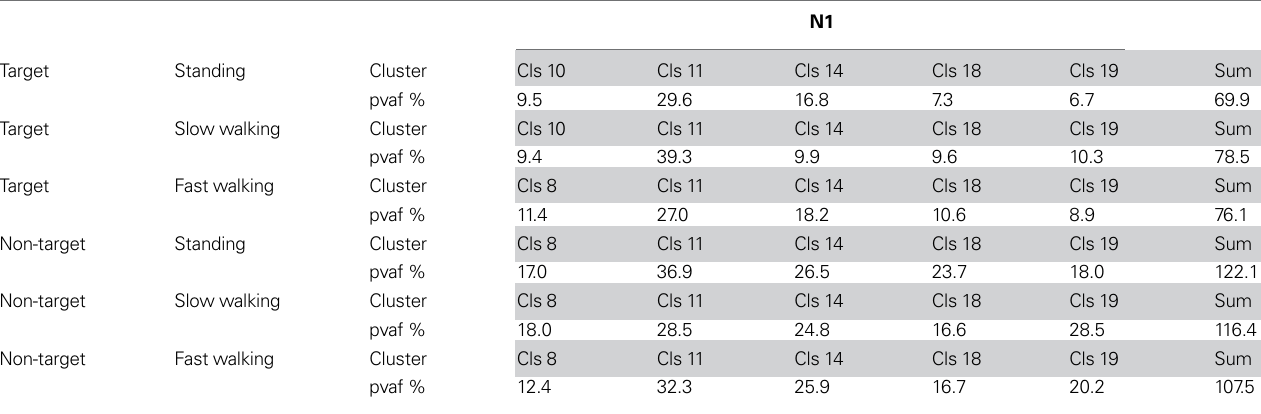
Table S1 | Percent of variance accounted for (pvaf) for the fi ve strongest clusters contributing to the surface measured N1 component, separately for targets and non-target stimuli while standing, slow walking, and fast walking.